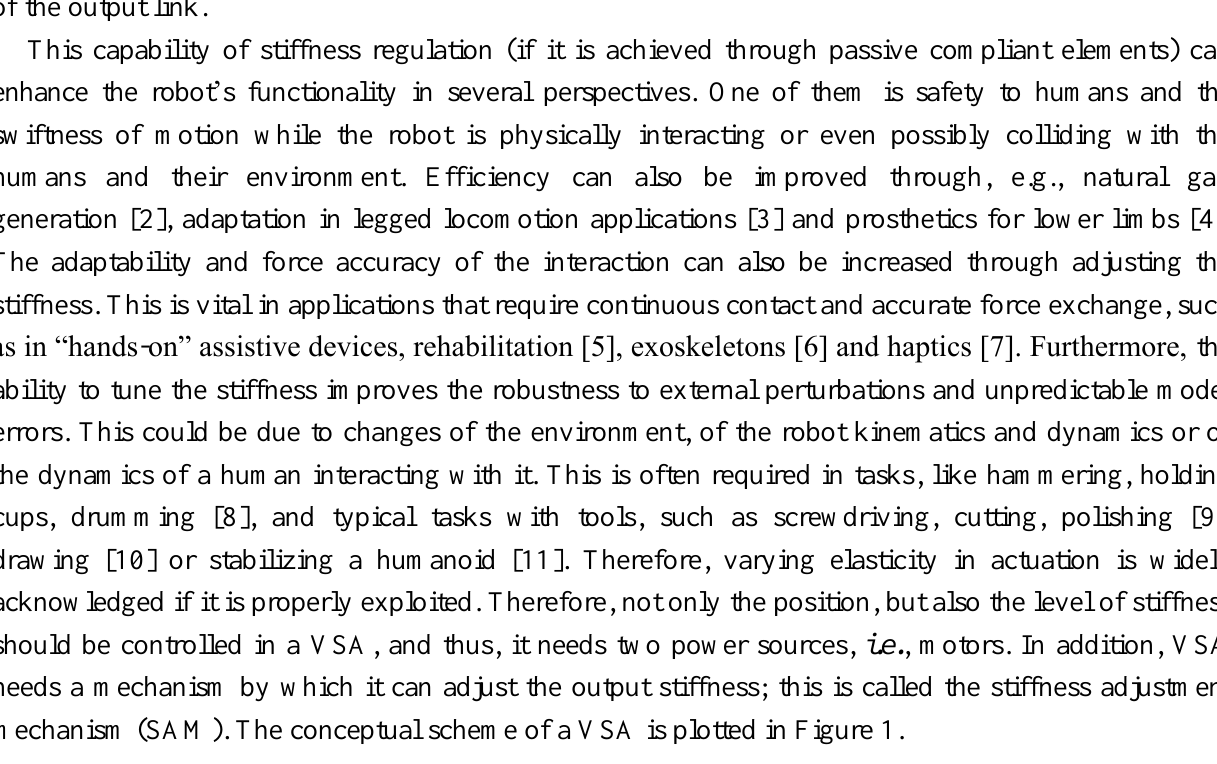
Figure 1. The concept of a stiffness adjustment mechanism and transmitted energy within the